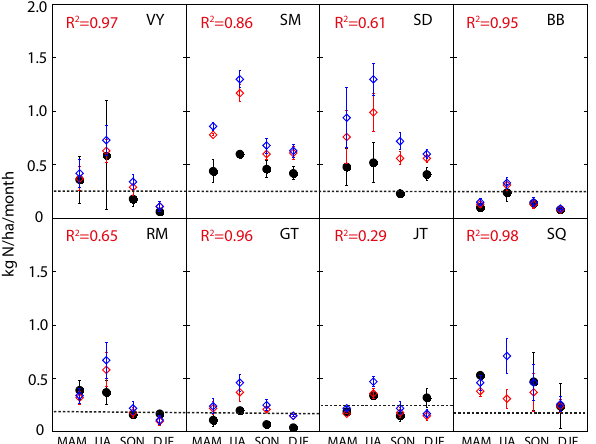
Figure 3. Seasonal variation of Nr deposition in select Class I ar- eas. Model values (open red diamond) correspond to only those species that are measured (closed black circle). Cost function values ( J p , open blue diamond) also include dry deposition of NH 3 , NO 2 , PANs, alkyl nitrate, and N 2 O 5 . Bars indicate standard deviation of monthly averages in the season. R 2 is squared correlation coeffi- cient for measured and modeled seasonal deposition. Dotted lines are for annual CLs divided by 12 in each site. MAM: March